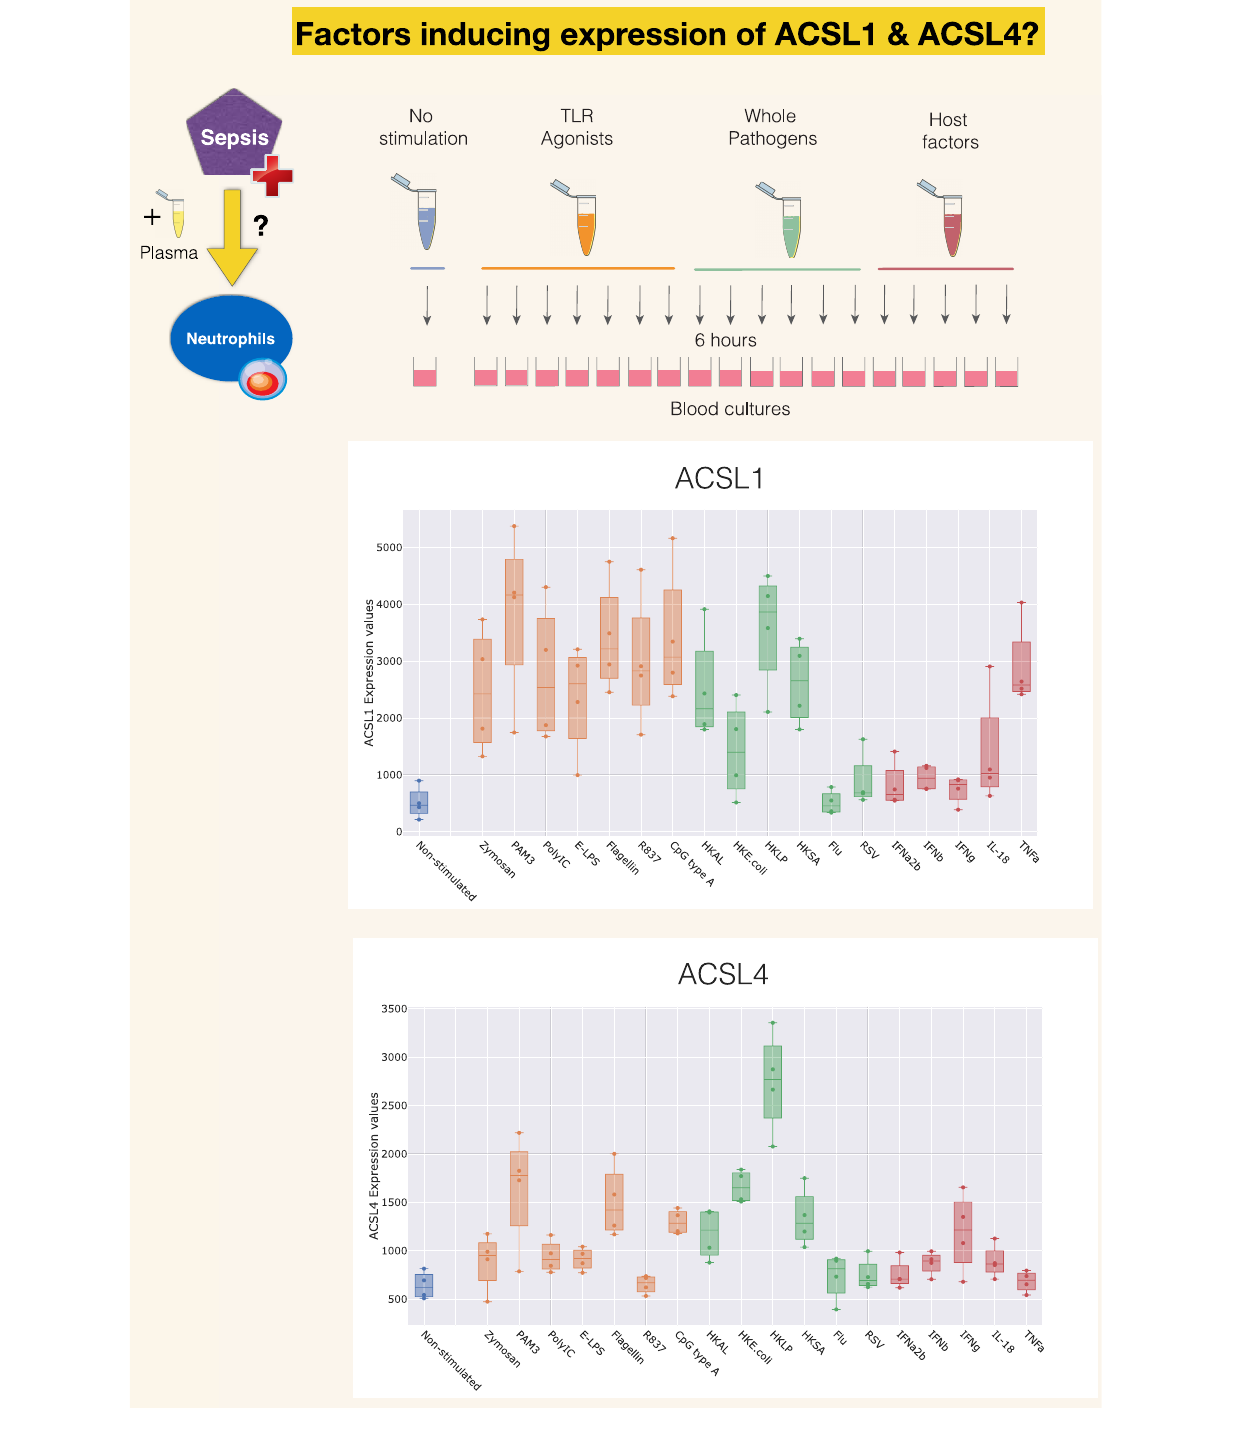
FIGURE 4 | Induction of ACSL1 and ACSL4 expression in response to immune stimulation. The data presented here was generated by Obermoser et al. (GSE30101) (102). The box plots show levels of abundance of ACSL1 and ACSL4 in whole blood of four healthy subjects incubated for 6h. at 37 ◦ C with 18 different immune stimuli or left unstimulated. Conditions included Toll-like receptors agonists PAM3, Zymosan, Poly IC, E-LPS, Flagellin, R837, CpG Type A, heat-killed Escherichia coli (HK E. coli ), heat-killed Legionella pneumophila (HKLP), heat-killed Acholeplasma laidlawii (HKAL), and heat-killed Staphylococcus aureus (HKSA); live influenza A virus (Flu) and live respiratory syncytial virus (RSV), and the host-derived immunostimulatory molecules IL18, TNF- α , IFN- α 2b, IFN- β , IFN- γ .